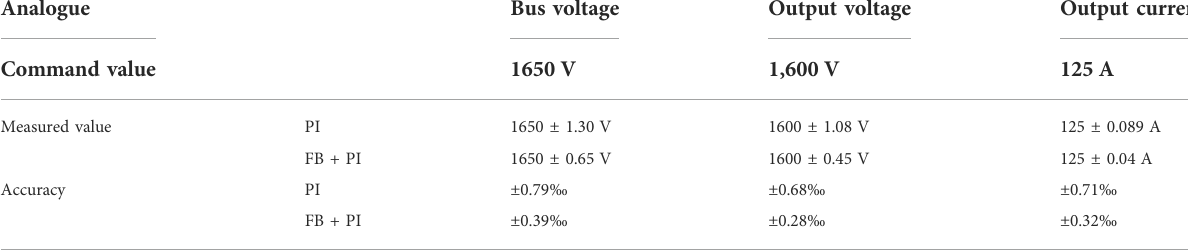
TABLE 5 Steady-state control accuracy of each parameter under regular grid operating